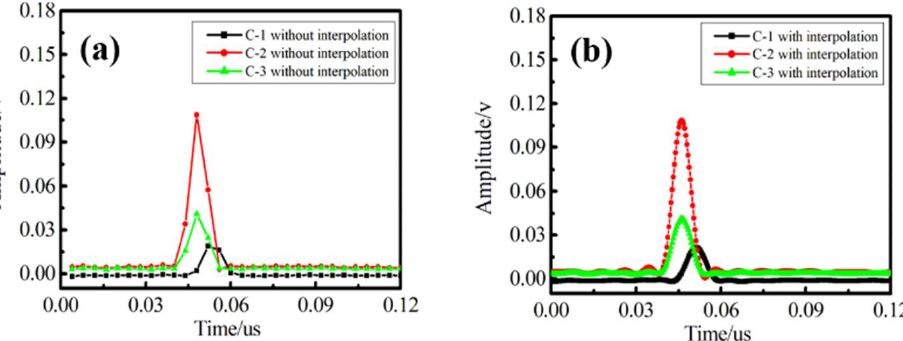
Figure 5. Comparison of echo pulse interpolation results. ( a ), Due to a small number of sampling points, the position corresponding to the pulse peak is prone to deviation, such as the black curve corresponding to channel C-1. ( b ), The pulse waveform is significantly improved, and the time position corresponding to the peak is more stable, which is conducive to obtain a more accurate peak change trajectory.